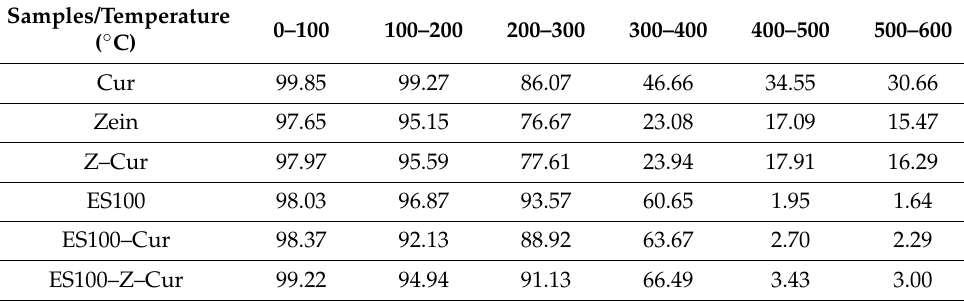
Figure 6. TGA curves of pure Cur, zein, released self-assembled Z–Cur, ES100, ES100–Cur, and ES100–Z–Cur. Table 1. Mass residues at different temperature range obtained from TGA curves.